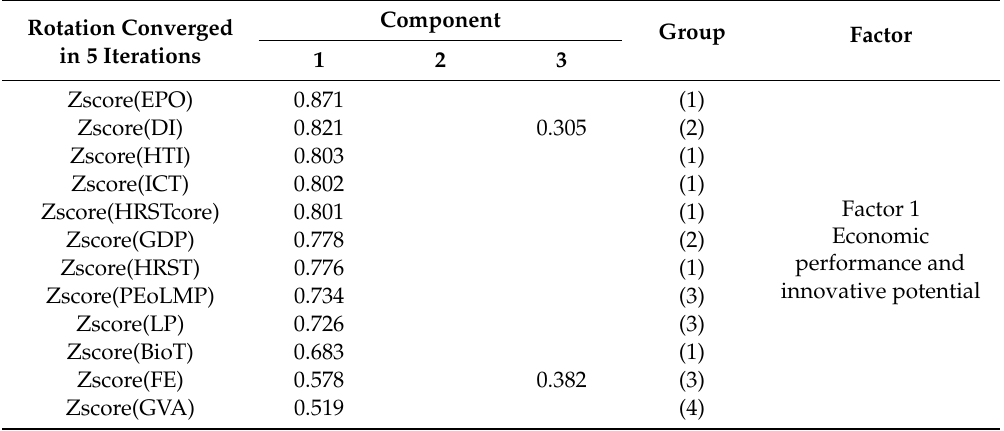
Table 6. Output factors—rotated component matrix (source: own calculation and elaboration). Rotation